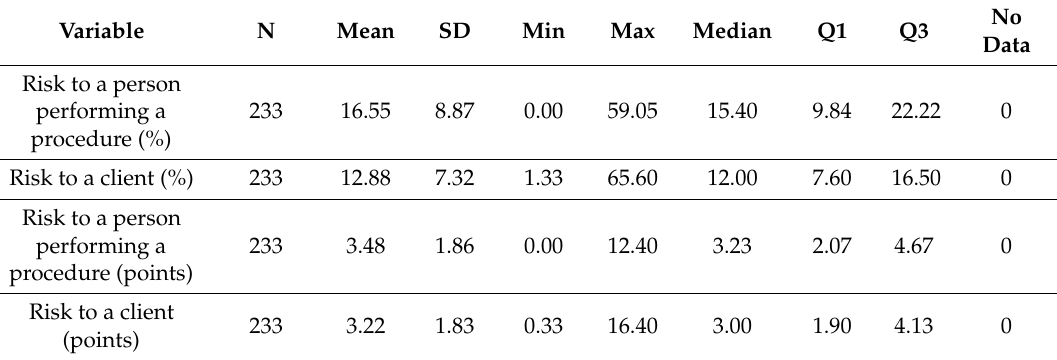
Table 3. Tattoo risk scoring results * and converted scores